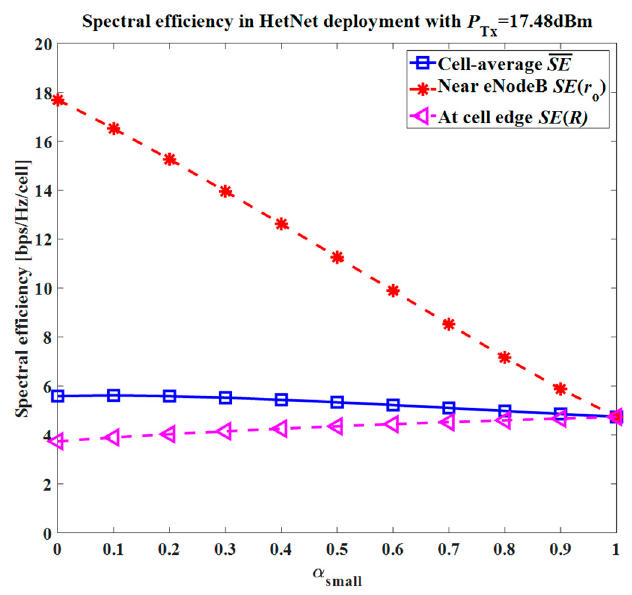
Figure 13. Spectral e ffi ciency for the small cell as a function of distance and α small in the HetNet deployment with uniformly distributed small